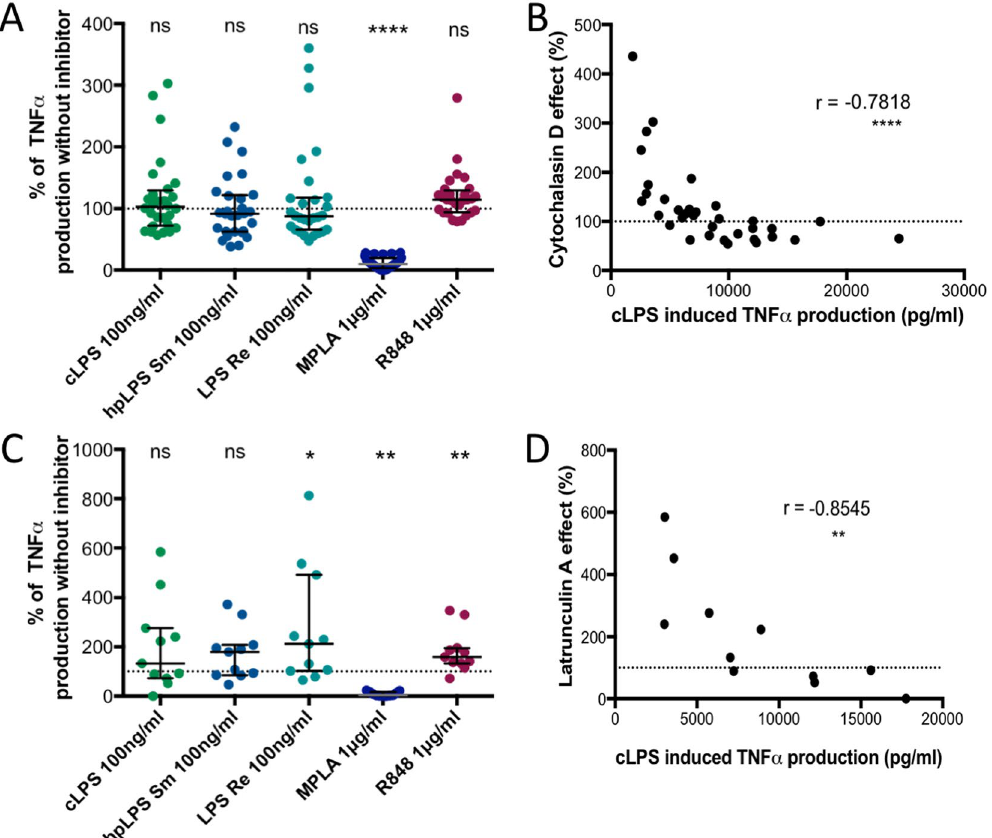
Figure 6. TNF production in the presence of actin polymerization inhibitors. ( A ) Inhibition by 3 µ M cytochalasin D of TNF production by human adherent mononuclear cells activated by either conventional smooth E. coli O111:B4 LPS (cLPS) (100 ng/ml), highly purified S. abortus equi LPS (hpLPS) (100 ng/ml), highly purified rough S. minnesota LPS (ReLPS) (100 ng/ml) or MPLA (1 µ g/ml) for different donors. ( B ) Correlation between the levels of TNF produced in response to conventional E. coli LPS in absence (horizontal axis) or in the presence (vertical axis) of cytochalasin D. ( C ) Similar experiments performed with 2 µ M latrunculin A. ( D ) Correlation between the levels of TNF produced in response to conventional E. coli LPS in absence (horizontal axis) or in the presence (vertical axis) of latrunculin A. Neither cytochalasin D nor latrunculin A affected the cytokine production in the absence of agonists (data not shown). Each dot represents one individual donor. Results are expressed as percent of the individual responses in the absence of inhibitors ( A , C ) or as absolute levels of TNF ( B , D ). * p ≤ 0.5; ** p < 0.01; **** p <